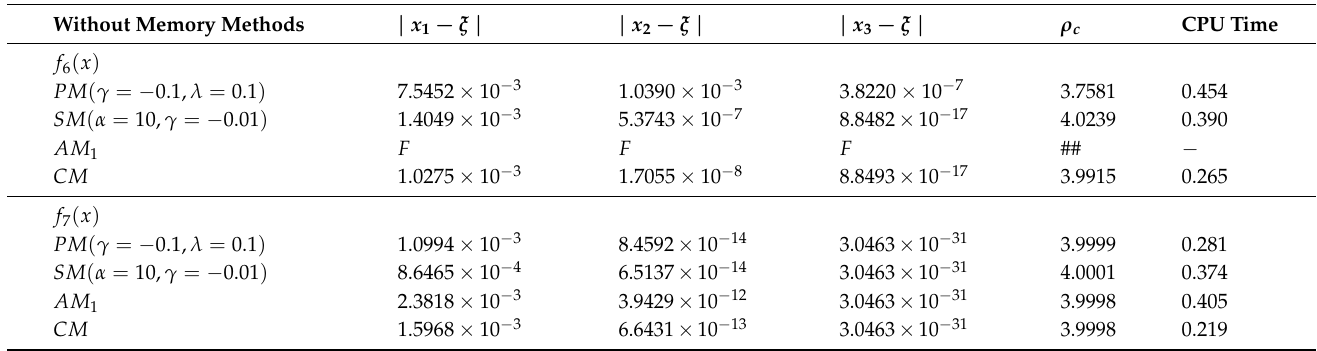
Table 4. Comparison of the different methods without memory for real-life problems.